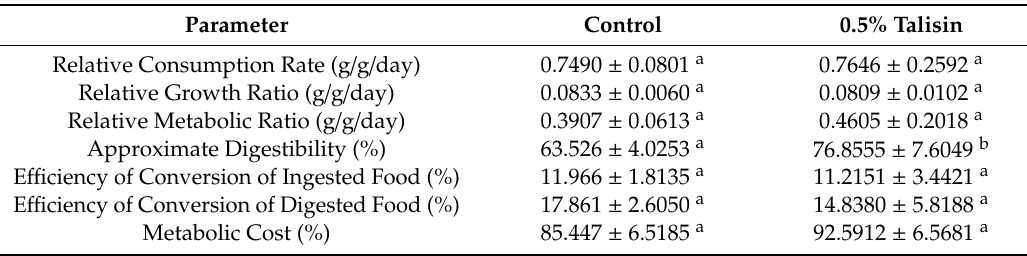
Table 2. Nutritional parameters in control and experimental (0.5% talisin-fed) fifth-instar Spodoptera frugiperda